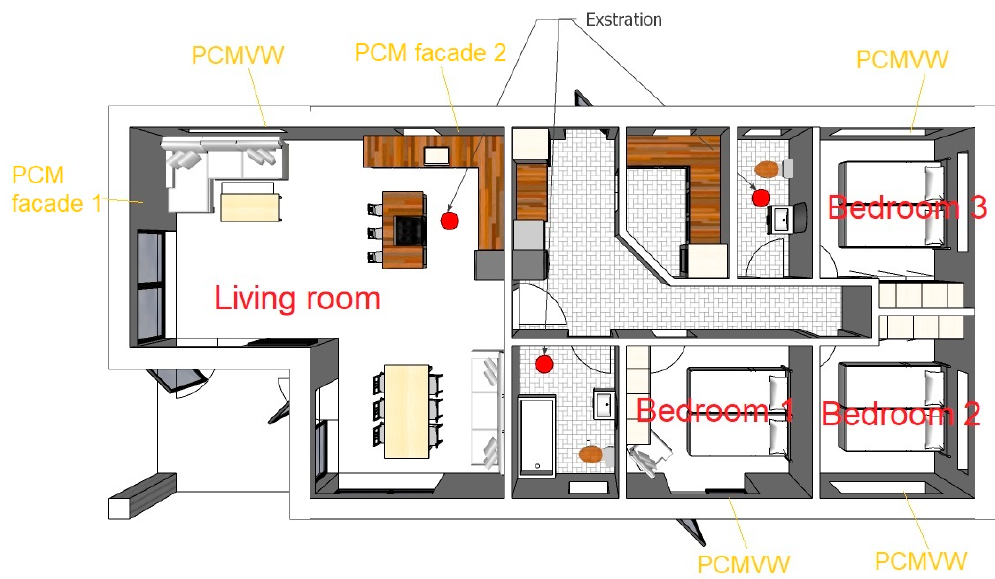
Figure 2. The room ID and PCM ventilation window (PCMVW) and PCM façade locations.